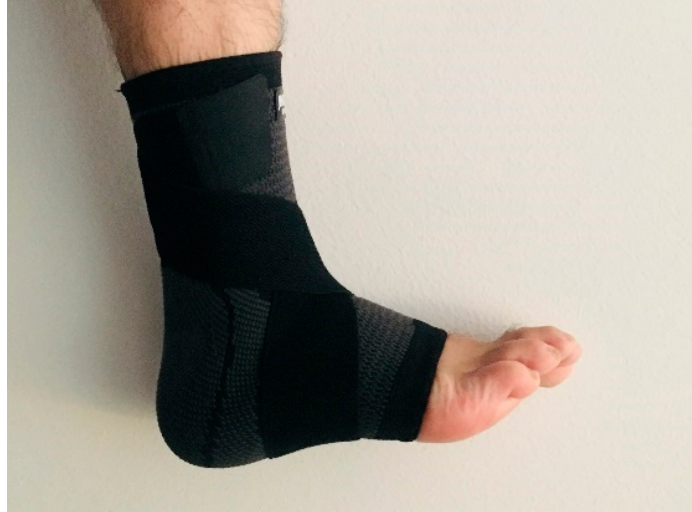
Figure 9. A useful orthosis for simulating ankle paralysis.